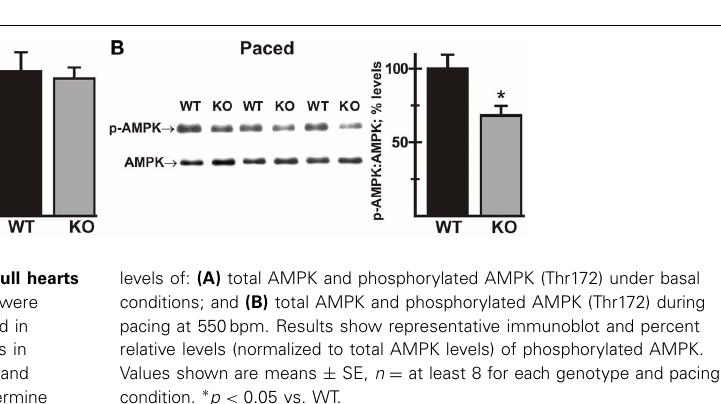
FIGURE 8 | Phosphorylation of Akt in wild-type and AE3-null hearts subjected to atrial pacing in vivo . WT and AE3-null (KO) mice were anesthetized, instrumented, and subjected to pacing as described in Figure 2 . Ventricular tissue was harvested under basal conditions in instrumented controls or during pacing at 550bpm. Immunoblot and densitometric analyses of homogenates were carried out to determine